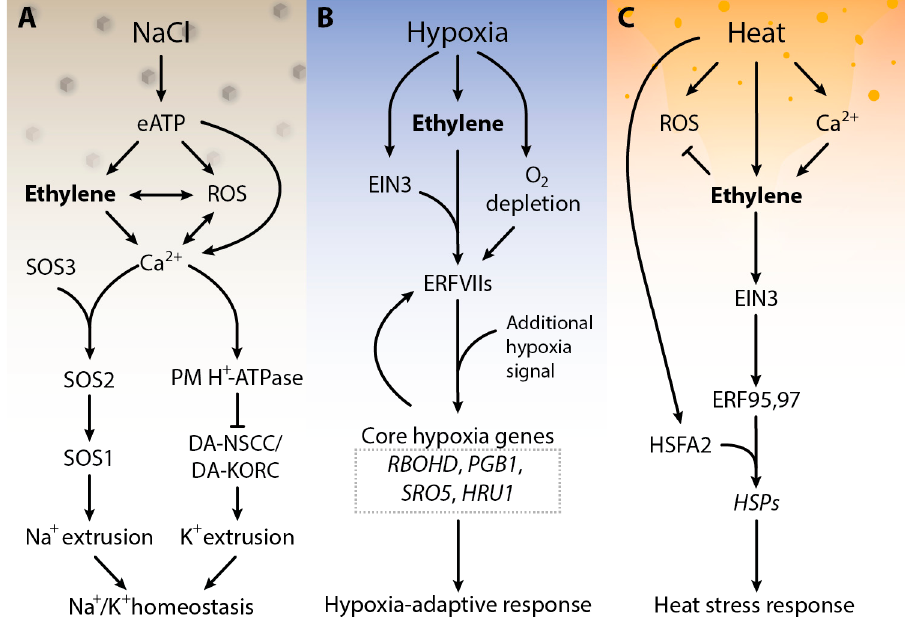
Figure 1. Schematic presentation of salt ( A ), hypoxic stress ( B ) and heat stress (HS) ( C ) signaling response in plants. Under salt stress, when Na + ions are sensed, extracellular ATP is generated, which results in the accumulation of ROS and cytosolic calcium (Ca 2+ )cyt. Consequently, the extracellular eATP triggers ethylene signaling which interacts with ROS and (Ca 2+ )cyt, ROS and ethylene, and ethylene and (Ca 2+ )cyt regulates the plasma membrane Na + /H + antiporter and H + -ATPase. Additionally, ethylene can also directly initiate the SOS signaling pathway. Subsequently, the